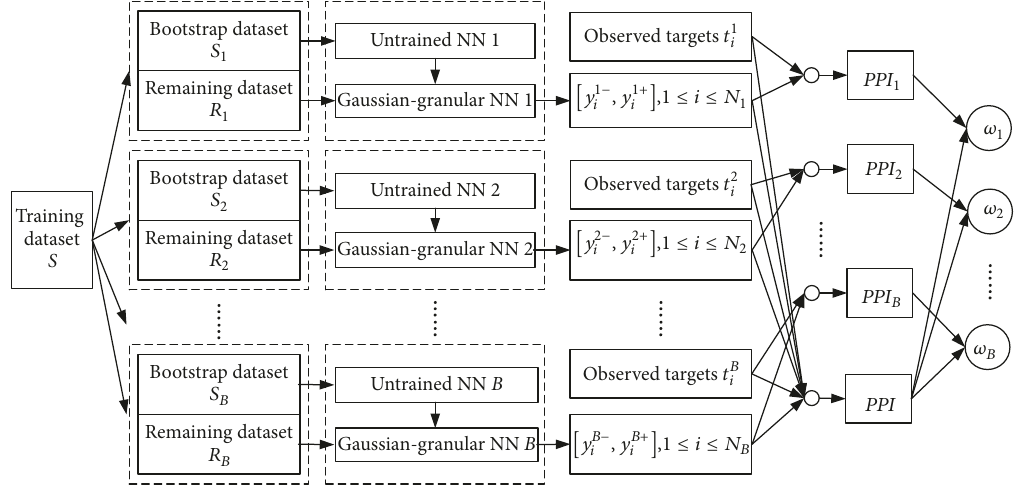
Figure 2: Training process of the proposed distributed